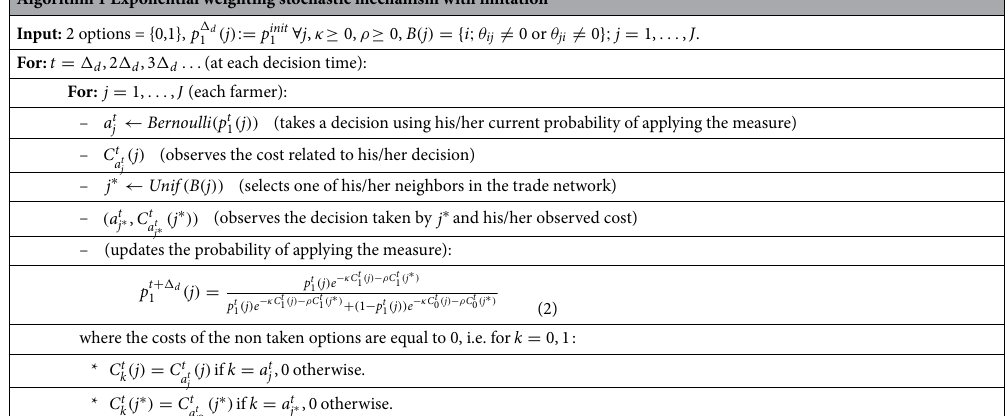
Algorithm 1 Exponential weighting stochastic mechanism with